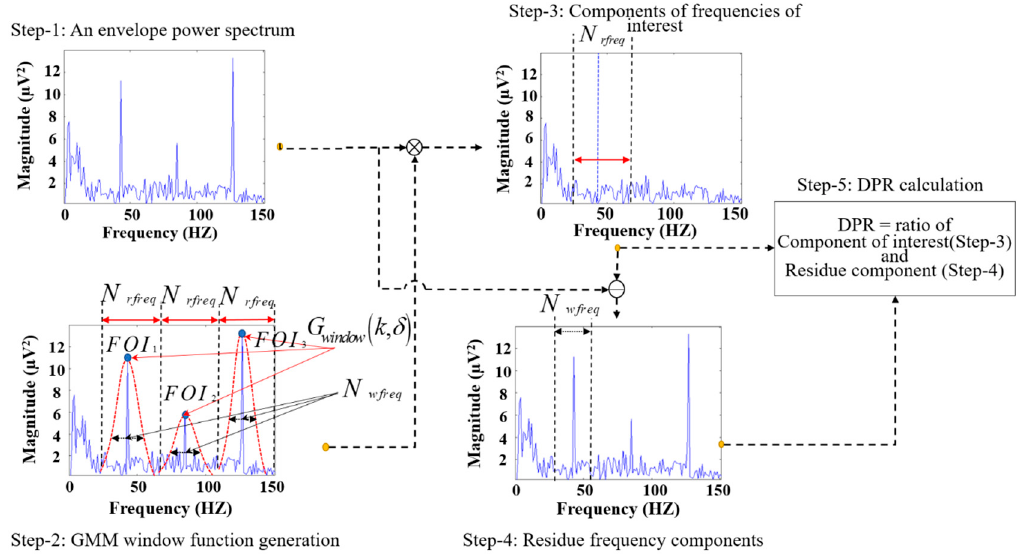
Figure 5. Evaluation of the IMFs by computing the degree-of-presence ratio (DPR) over the frequency of the interest and its harmonics. GMM, Gaussian mixture model; FOI, frequency of interest.